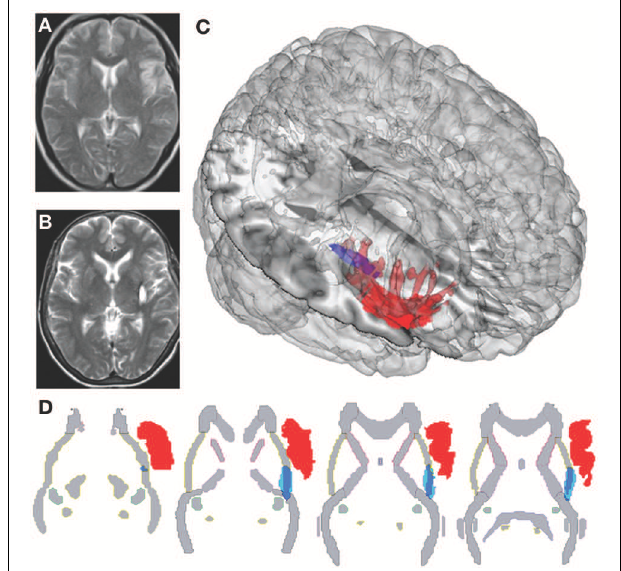
FIGURE 1 | Different plots of IL and SL brain damage localization. (A) Structural MRI of IL, with sequence T2 showing the right insular cortex lesion. (B) Structural MRI of SL, with sequence T2 showing damage to the right posterior putamen, capsula extrema, claustrum . (C) Three-dimensional rendering of lesion-traced MNI-normalized brain lesions of IL and SL plotted onto a standard T1 glass brain with the Mango software. (D) Overlap of lesion-traced MNI-normalized brain lesions of IL and SL and the JHU-Atlas of white matter, showing differential affectation of external capsule in both